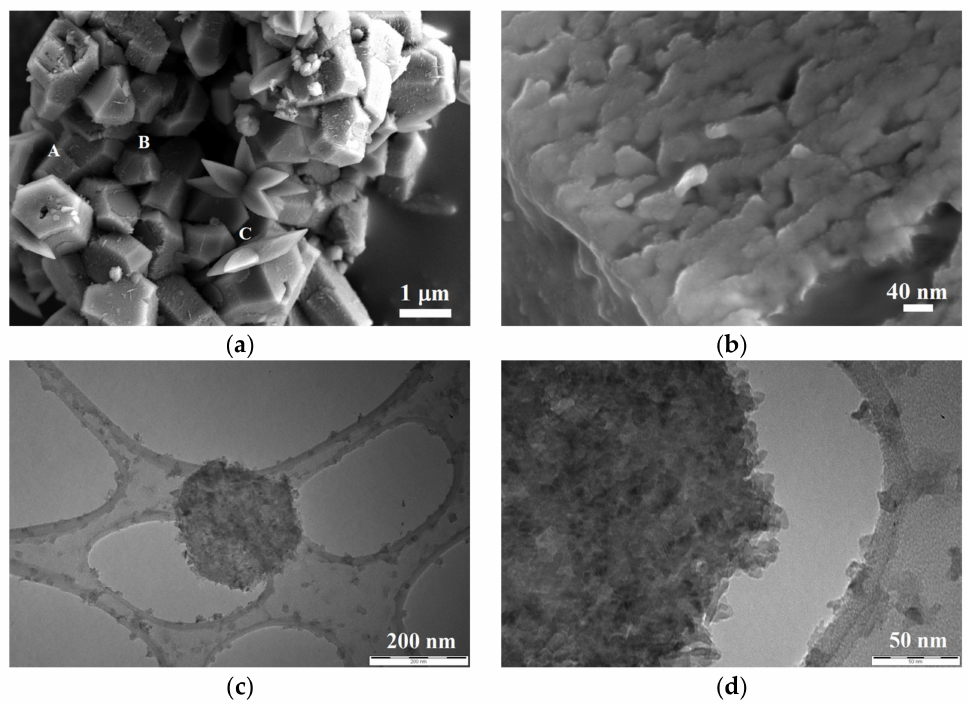
Figure 5. SEM and TEM observations of the N ANO LAQ suspension sample after drying under nitrogen atmosphere: ( a ) low magnification SEM image showing the crystalline prismatic (A and B) and scalenohedral (C) habits present in the sample after drying on the SEM specimen stab; ( b ) high magnification SEM image of the surface of a prismatic crystal indicating that each crystal was composed of a dense nanoparticles aggregation; ( c , d ) TEM images representing a hexagonal aggregate composed of nanoparticles all ≤ 10 nm in size.